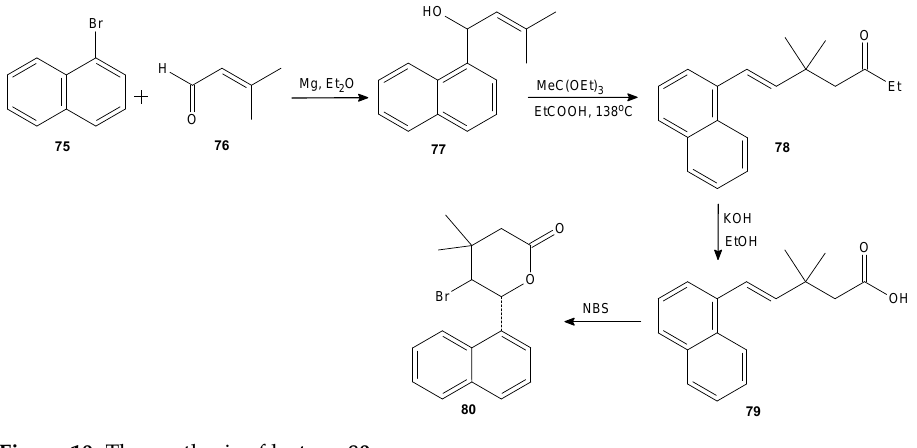
Figure 10. The synthesis of lactone 80 .